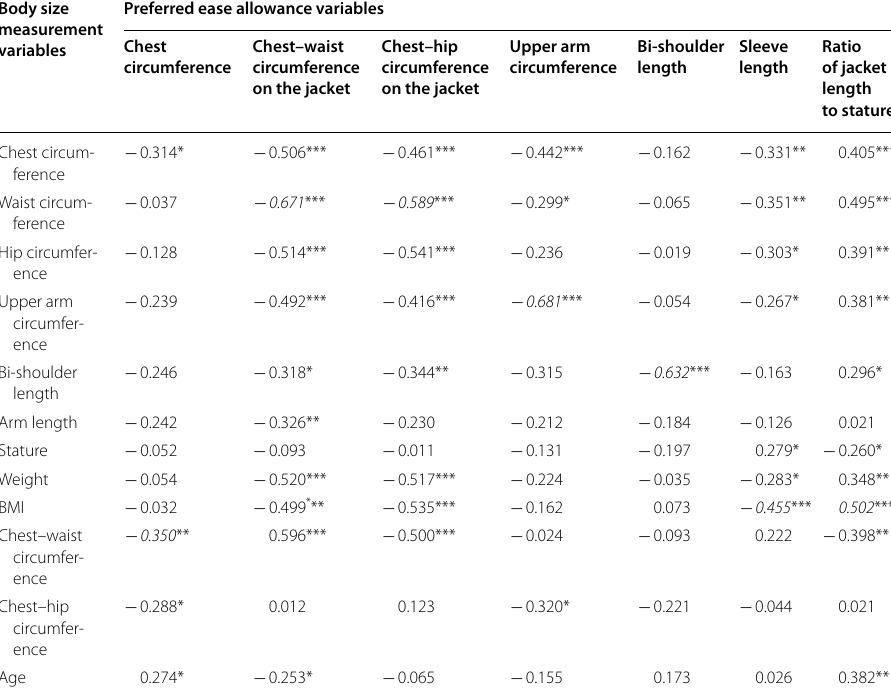
Table 5 Correlation coefficients between the body size measurements and preferred ease